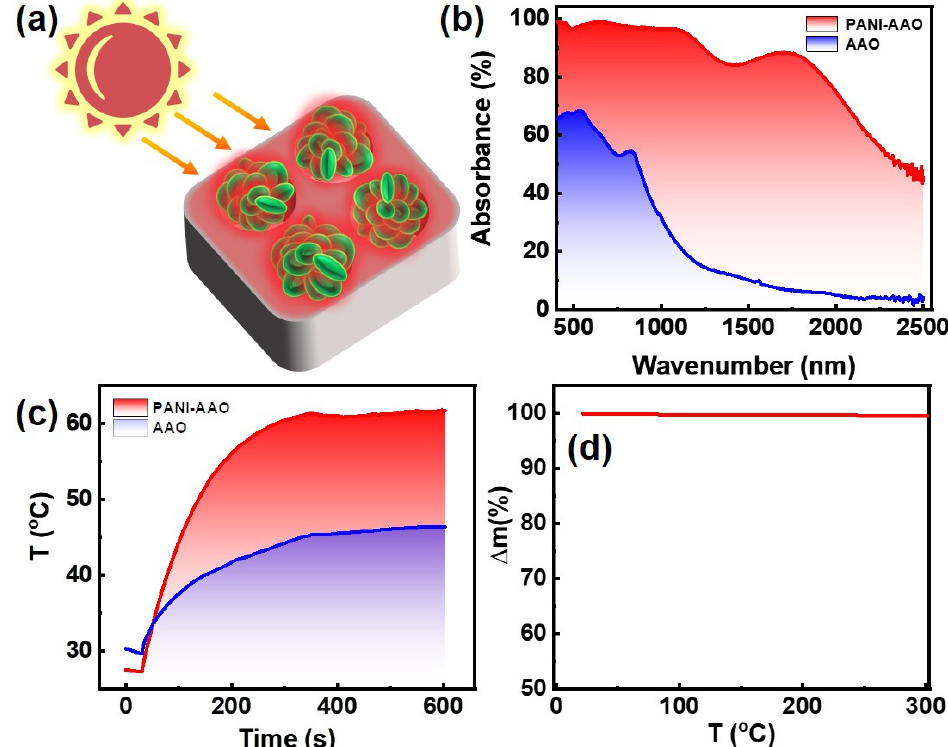
Figure 2. The photothermal conversion performance of the solar absorber. ( a ) The abridged schematic illustration of the solar heating effect. ( b ) The absorption spectrum of the AAO and AAO-PANI. ( c ) Time-dependent temperature variation of the AAO and PANI-AAO under one solar irradiation. ( d ) TGA curves of PANI-AAO.